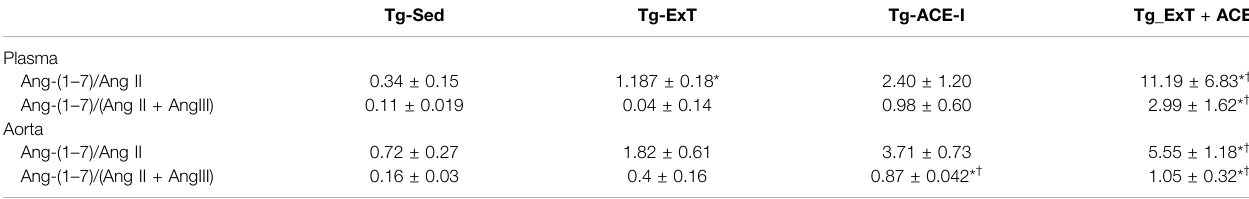
TABLE 1 | Plasma and aortic ratio of Ang-(1 – 7) to Ang II re fl ecting the activity of classical and counter-regulatory axes of